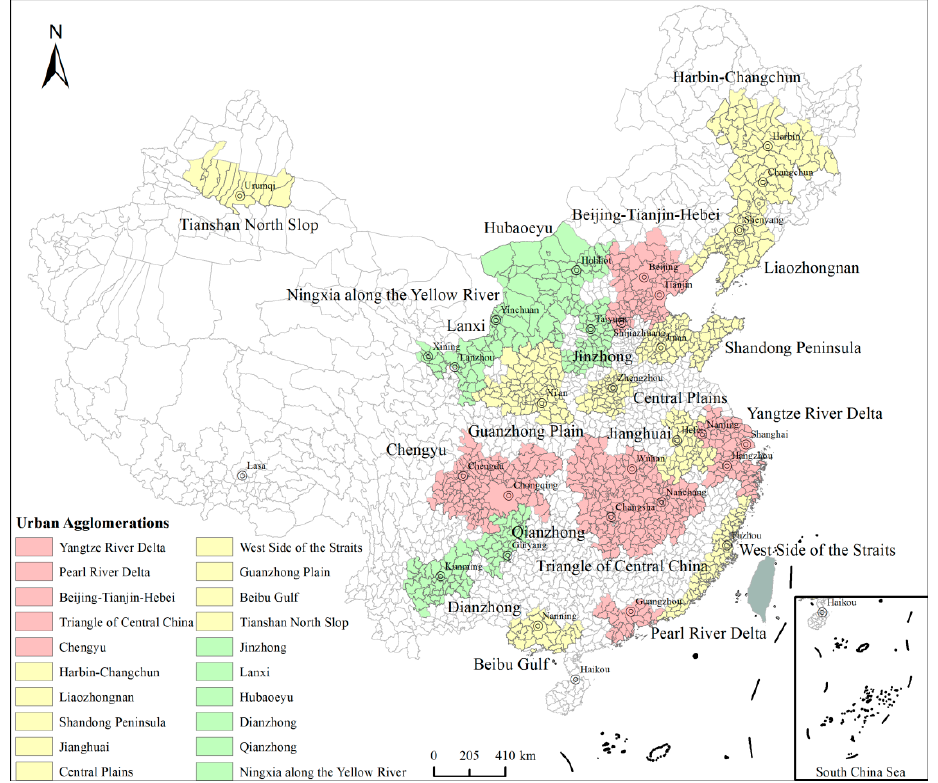
Figure 6. Distribution structure of urban agglomeration following the “5 + 9 + 6” plan of China in